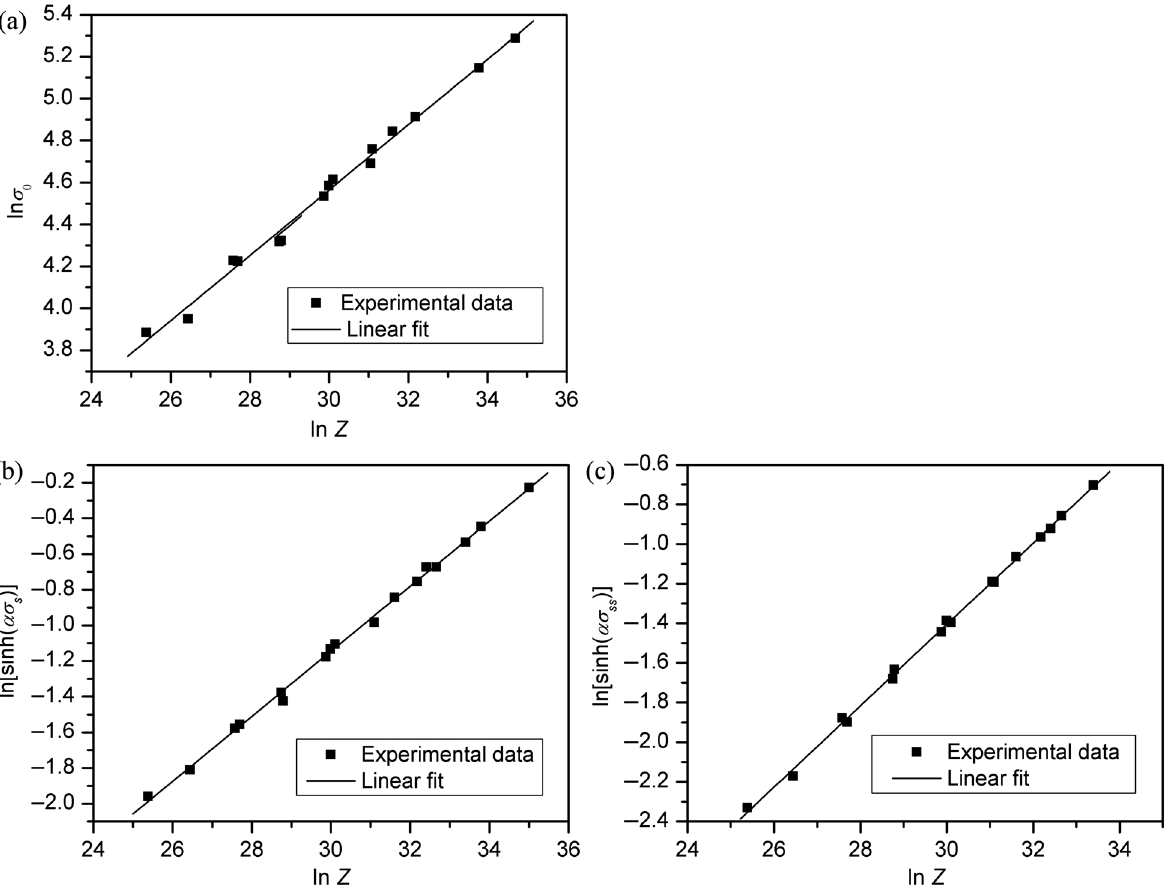
Figure 6: Regressed (a) initial stress, (b) saturation stress and (c) steady-state stress under various conditions.